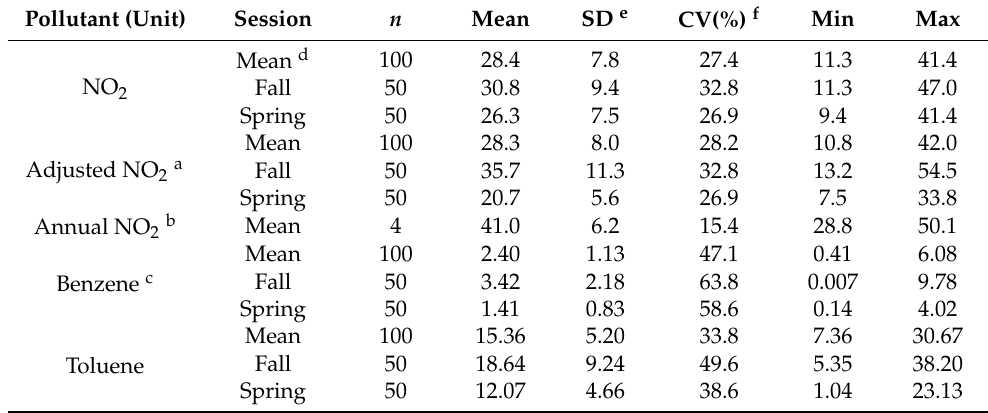
Table 3. Statistical summary of measured NO 2 and BTX, and temporally adjusted NO 2 concentrations (unit: µ g/m 3